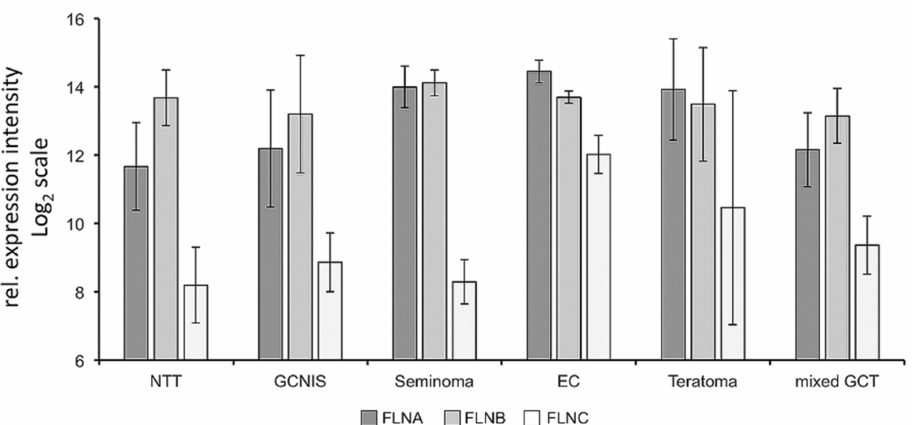
Figure 2. FLNA and FLNB are found with high prevalence to be associated with human testicular cancers. The histograms depict cDNA microarray expression data of FLNA, FLNB and filamin C (FLNC) genes in germ cell tumor (GCT) tissues (germ cell neoplasia in situ (GCNIS), seminoma, embryonic carcinoma (EC), teratoma and mixed GCT). Normal testis tissue (NTT) served as control. Means ± SEM of three to four individual samples.